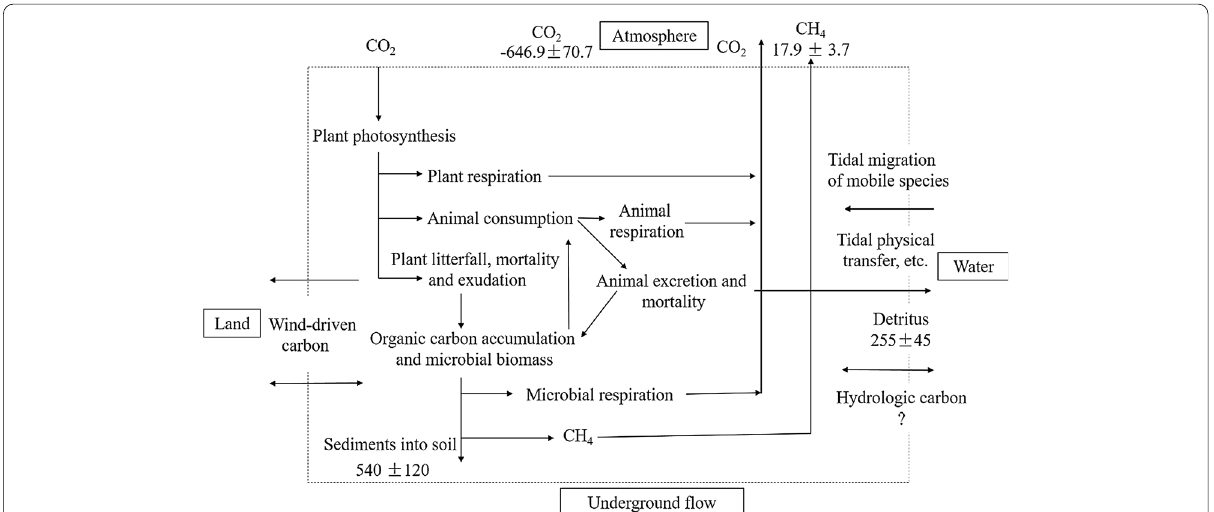
Fig. 7 Conceptual model illustrating the significant pathways of C flux across the estuarine wetland ecosystem. The large, dashed box represents the coastal/estuarine ecosystem. Negative-sign conventions for all fluxes indicate net fluxes into the wetland (g C m − 2 year − 1